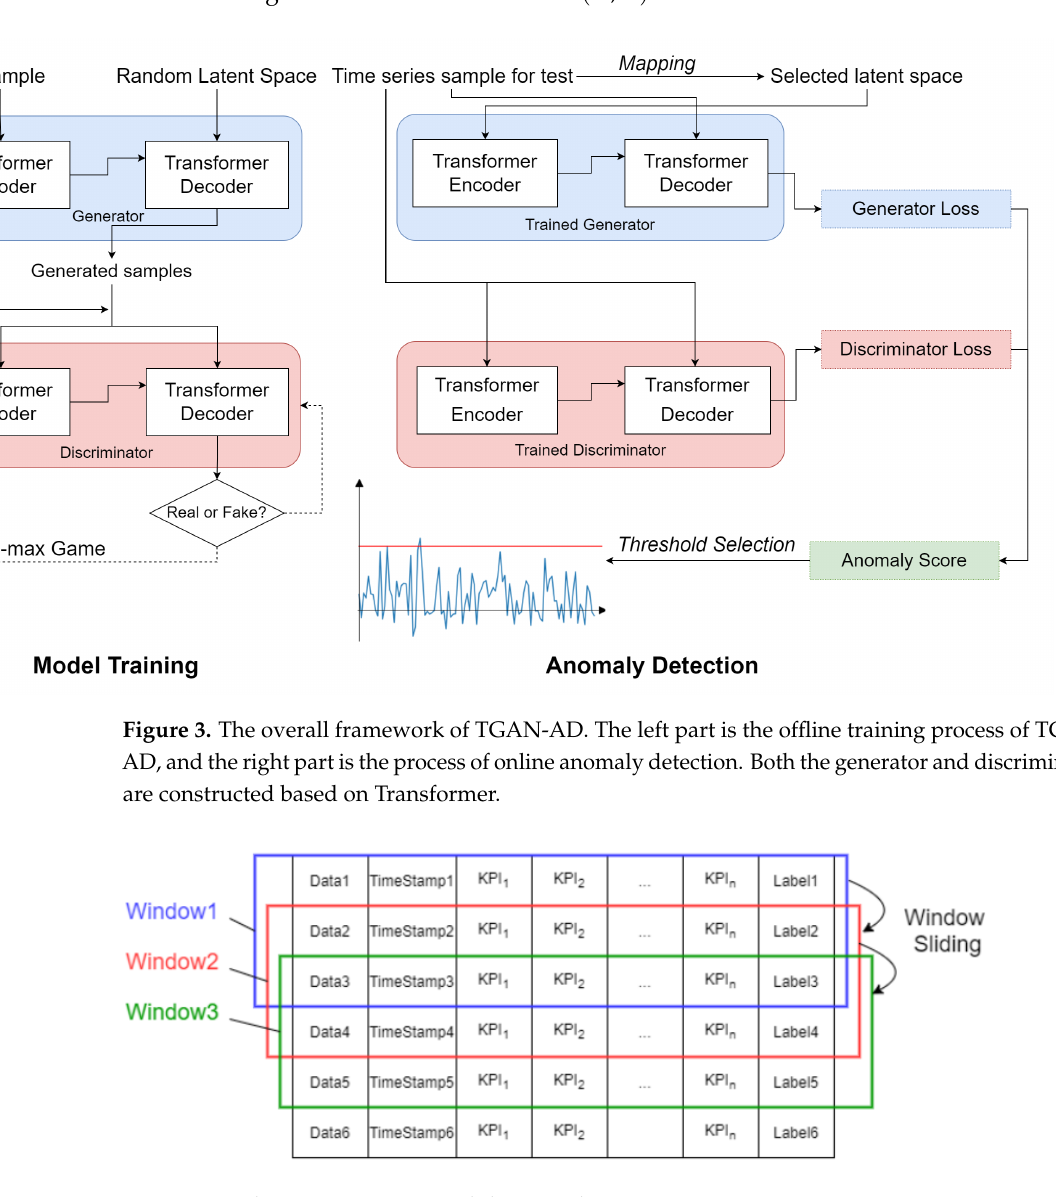
Figure 4. Multivariate time series sliding